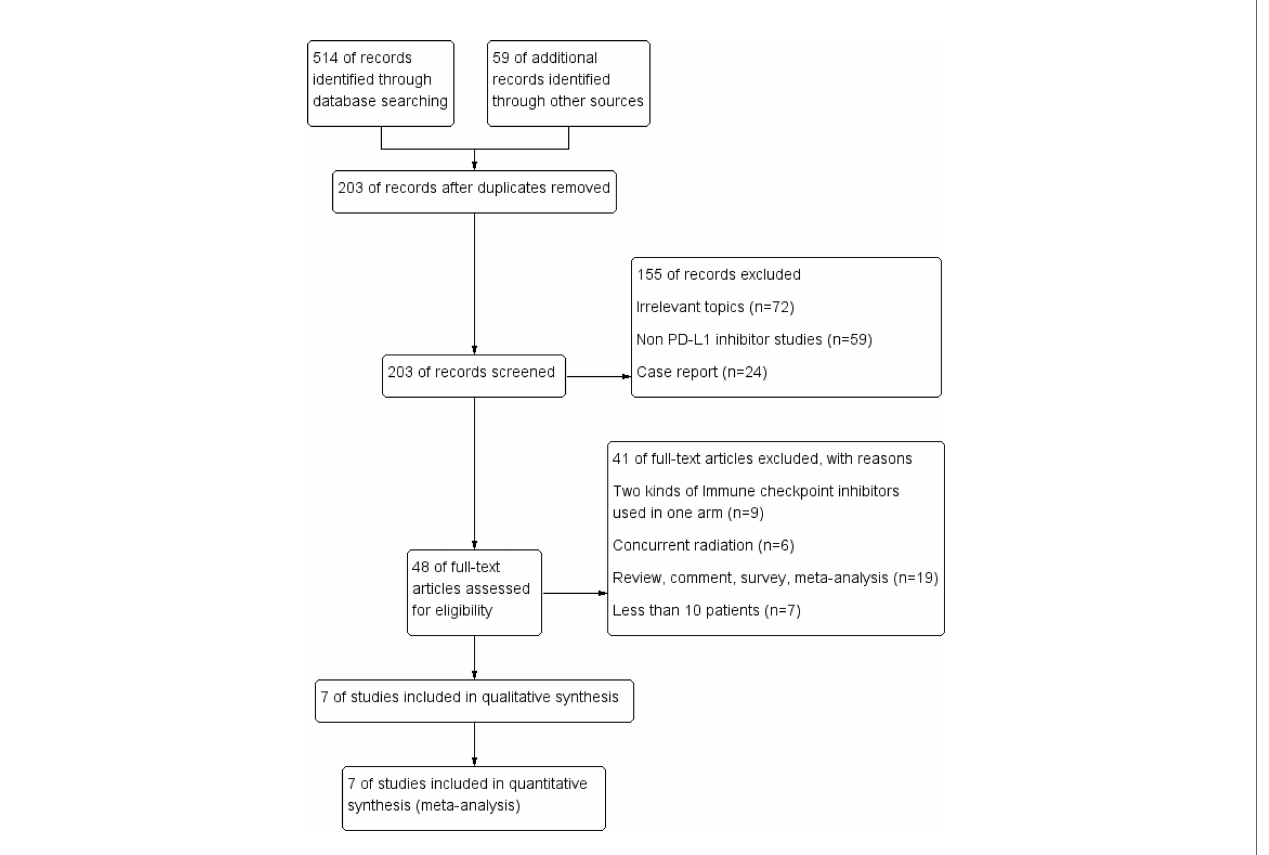
FIGURE 1 | PRISMA fl ow